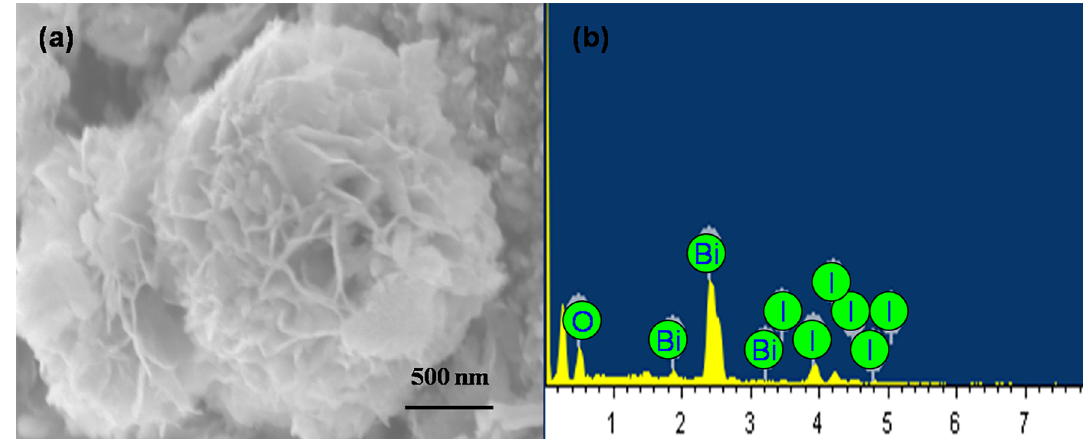
Figure.5a represents the time-dependent RhB dye concentration variation curve over different